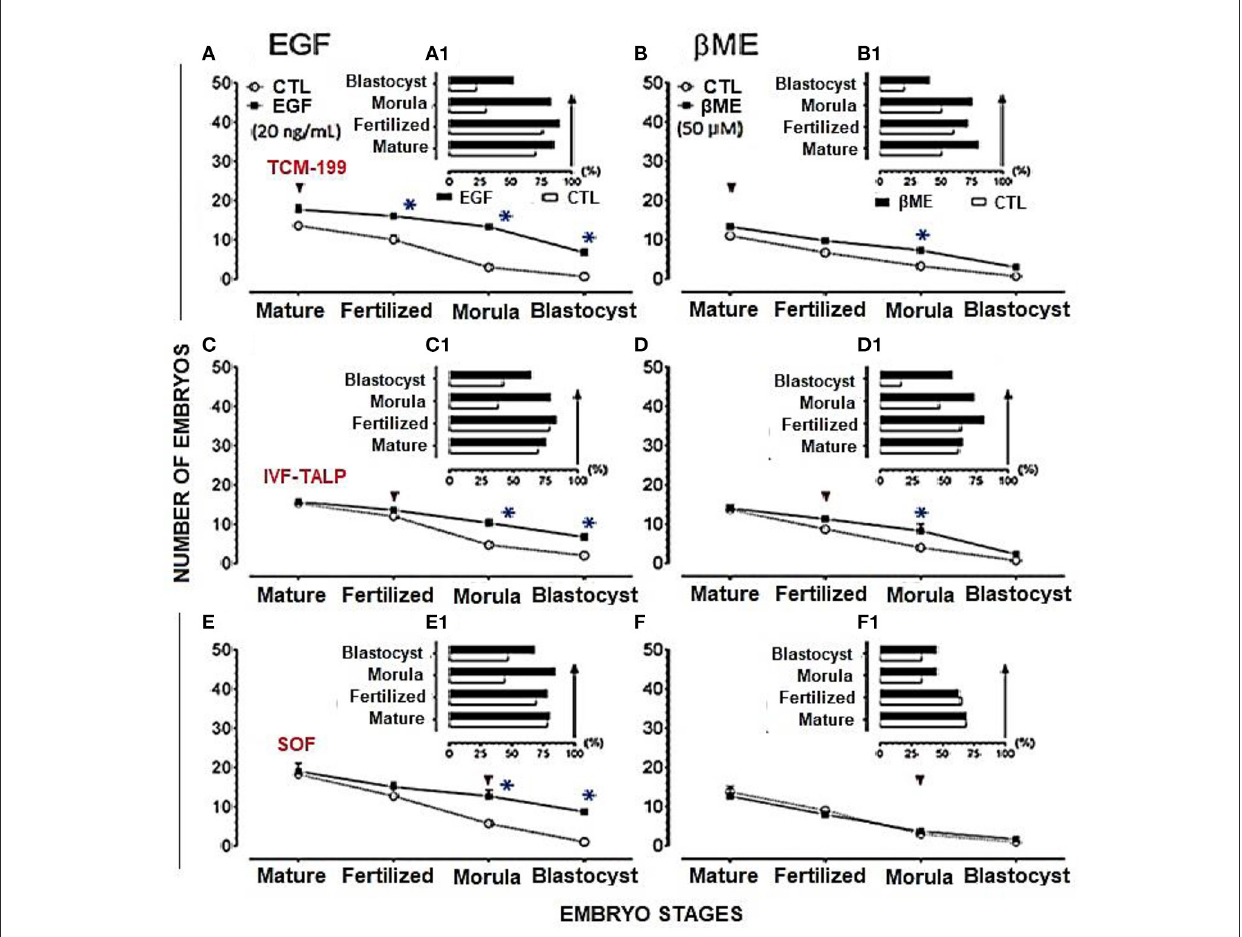
FIGURE3 Effects of EGF (20ng/mL) added to TCM-199, IVF-TALP, and SOF media, on buffalo embryo stages; oocyte maturation, fertilization, morula and blastocyst were shown in (A, C, E) , respectively. EGF (20ng/mL) characteristics on the developmental stages (%) of those embryos in vitro were shown in (A1, C1, E1) , respectively. Effects of β ME (50 µ M) added to TCM-199, IVF-TALP, and SOF media, on buffalo embryo stages; oocyte maturation, fertilization, morula and blastocyst were shown in (B, D, F) , respectively. β ME (50 µ M) characteristics on the developmental stages of embryos in vitro were shown in (B1, D1, F1) , respectively. Values were presented as mean ± SEM for three experiments (A–F) . Arrows denotes the stage in treated medium. Asterisk ( * ) denotes significance difference between each respective values (treated vs. CTL) at P <